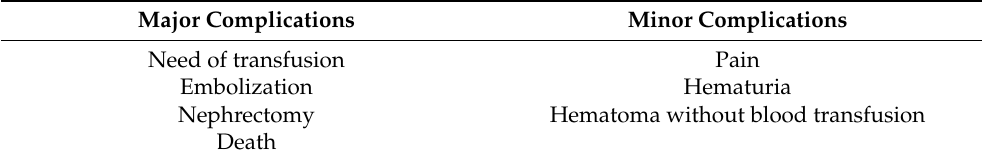
Table 1. Definitions of major and minor